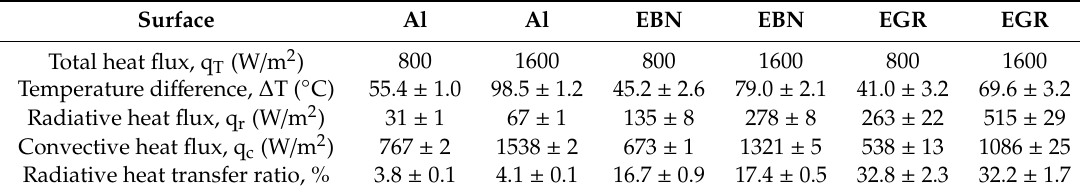
Table 8. The heat transfer rates by convection and radiation under natural convection.